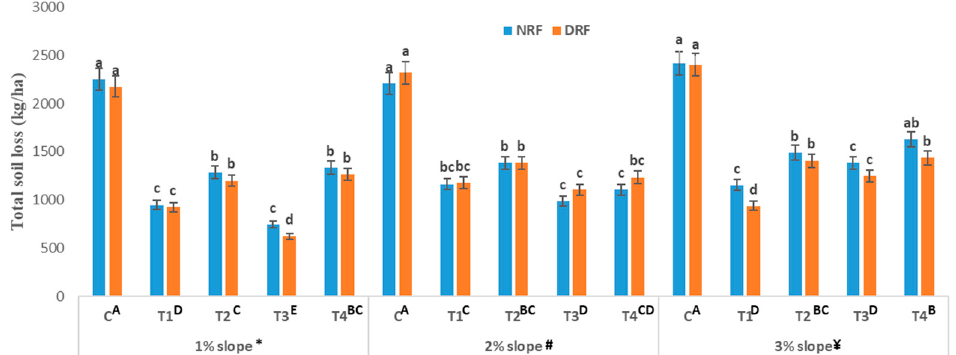
Figure 3. Effect of grass strips on total soil loss across variable slopes (1–3%) in normal and deficit rainfall years. ABCDE all differ significantly at the 1% level of significance between the treatments irrespective of slopes. abcd all differ significantly at the 5% level of significance between the treatments within a particular slope level in different rainfall situations. * #¥ all differ significantly at the 1% level of significance between the slopes. T 1 , the top and bottom Stylosanthes strip; T 2 , only the bottom strip of Stylosanthes ; T 3 , the top and bottom the Brachiaria strip; T 4 , only the bottom strip of Brachiaria